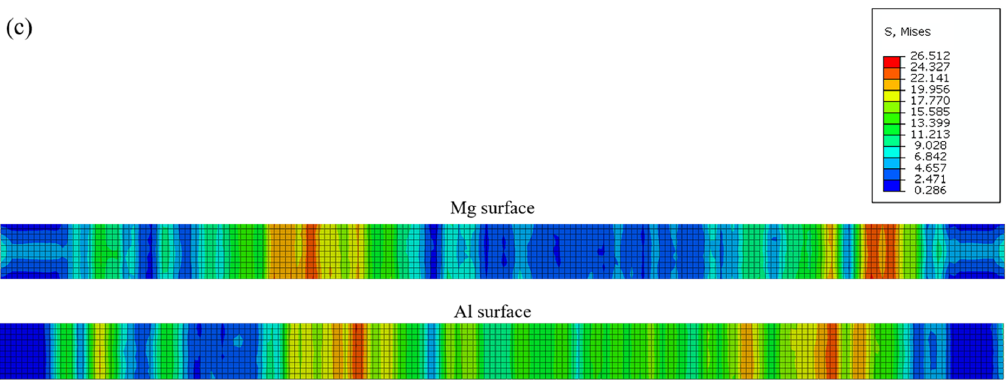
Figure 15. The residual stress of plate surface with different straightening projects: ( a ) straightening project 1; ( b ) straightening project 2; ( c ) straightening project 3.